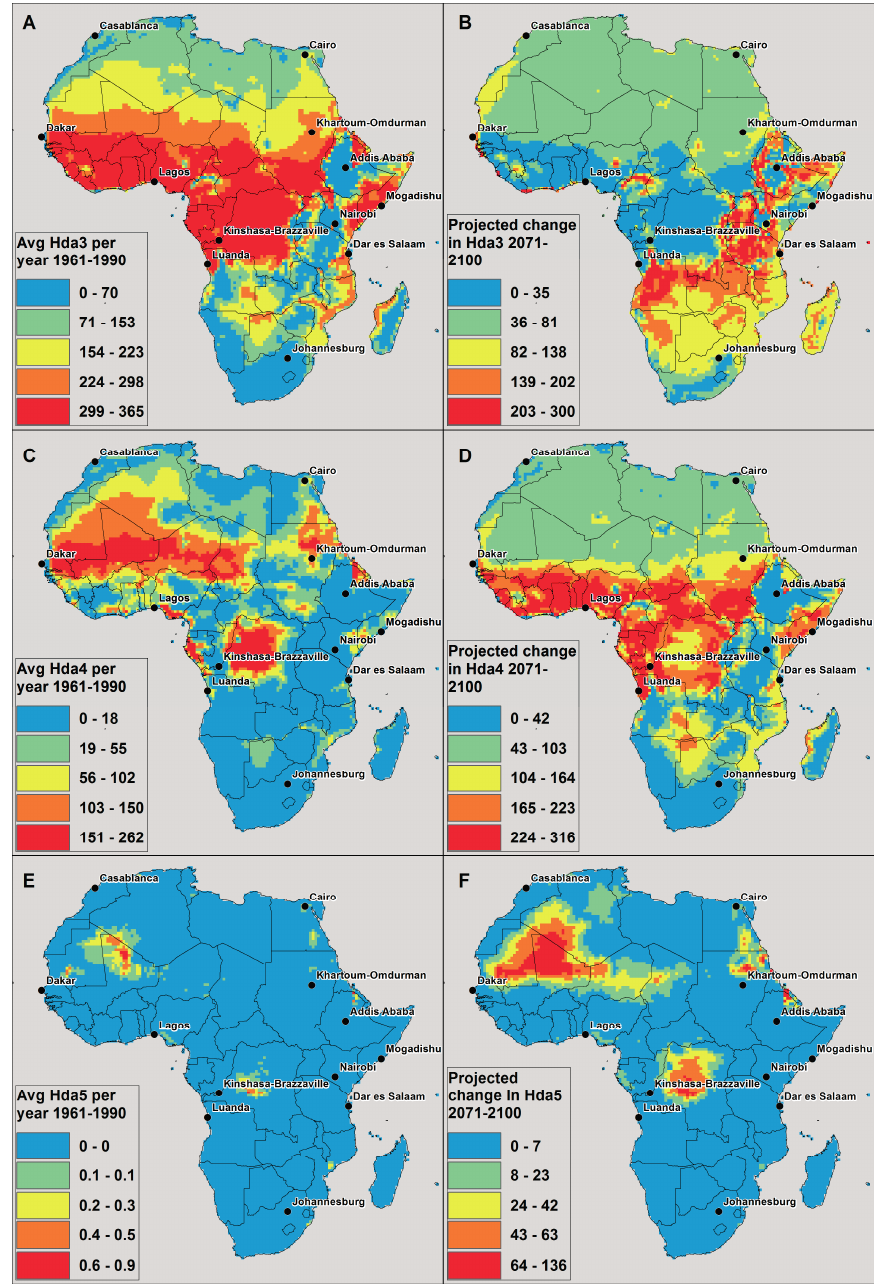
Figure 3. CCAM model derived ( A ) average number of Hda3 per year in present climate (1961–1990); ( B ) change in average number of Hda3 per year in 2071–2100 compared to 1961–1990; ( C ) average number of Hda4 per year in present climate (1961–1990); ( D ) change in average number of Hda4 per year in 2071–2100 compared to 1961–1990; ( E ) average number of Hda5 per year in present climate (1961–1990); ( F ) change in average number of Hda5 per year in 2071–2100 compared to